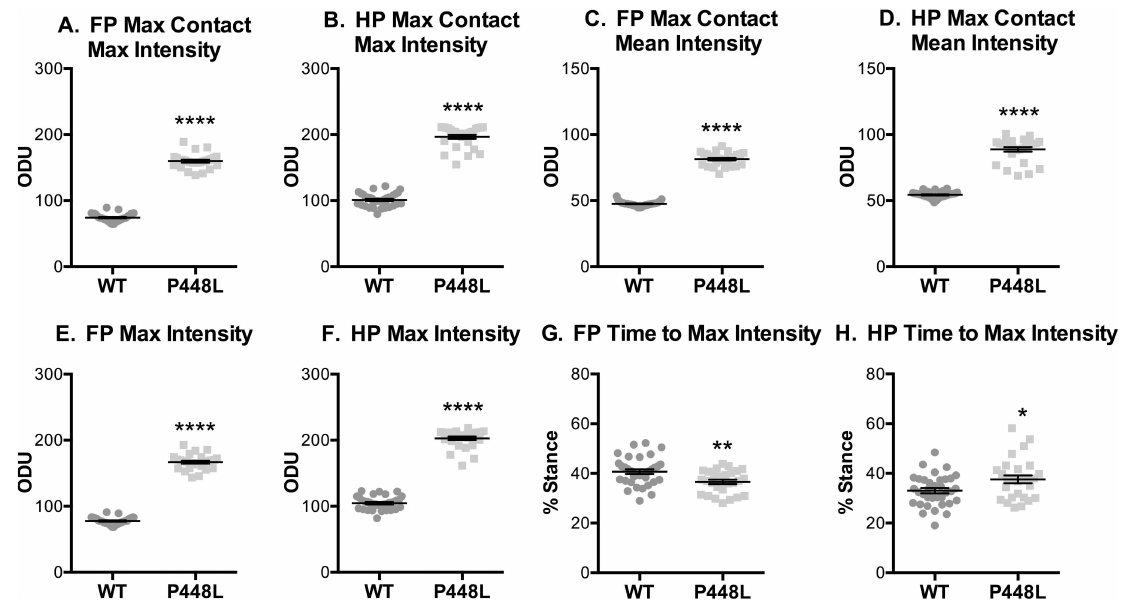
Fig 5. Paw Intensities. Fore paw and hindpaw measurements of greenlightintensitywith an opticaldensity green light thresholdof 0 to 255. These measurements include (A,B) the highestand (C,D) average pixel intensityduringthe time of maximumcontactwith the walkway. (E,F)This also includesthe highestintensityrecorded at any point duringstance phase and (G,H)the timeit takes to reach the highest intensityas represented as a percentage of the stance time. (FP = fore paw, HP = hindpaw, ODU = OpticalDensity Units, n = 12; * p < 0.05; ** p (cid:20) 0.01, **** p (cid:20) 0.0001).